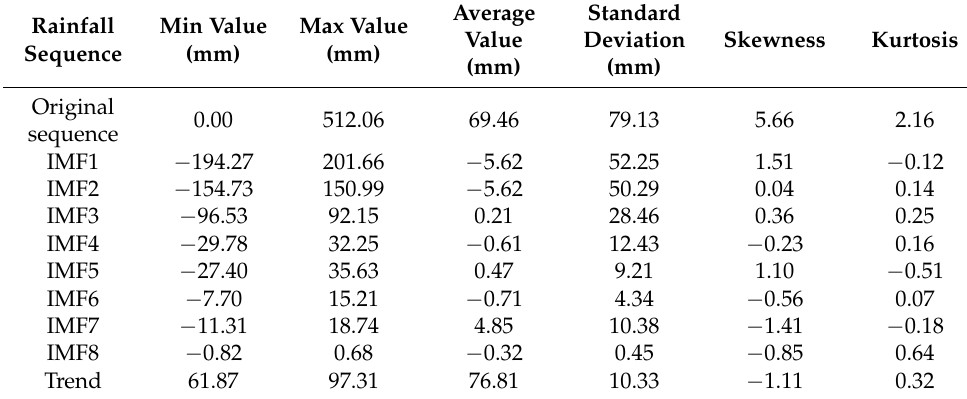
Figure 6. CEEMD decomposition results of month − by − month precipitation in Zhoukou City for 1978–2022. Table 1. Statistics of raw precipitation and decomposition